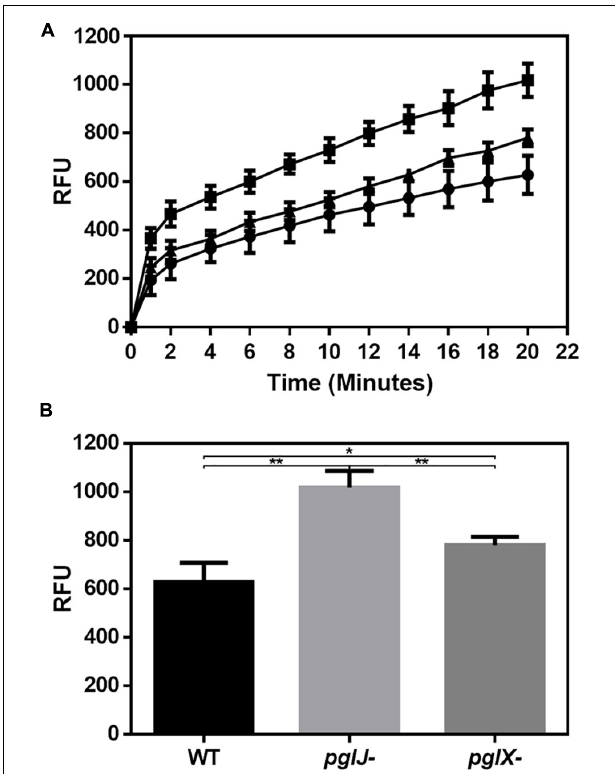
FIGURE 9 | Mutations in N-linked protein glycosylation decreased efflux in pglX- and pglJ - strains. (A) Accumulation of ethidium bromide in cultures of Cff WT (circle), pglJ- (square), and pglX- (triangle) over a time frame of 20 min. Relative fluorescent units (RFU) are indicated on the y -axis. (B) Bar graph depicting the relative fluorescence at t = 20 min. The error bars represent the standard error for each data set consisting of four biological replicates with three technical replicates each. ** p -value ≤ 0.001, * p -value ≤ 0.05 as determined by a two-tailed t-